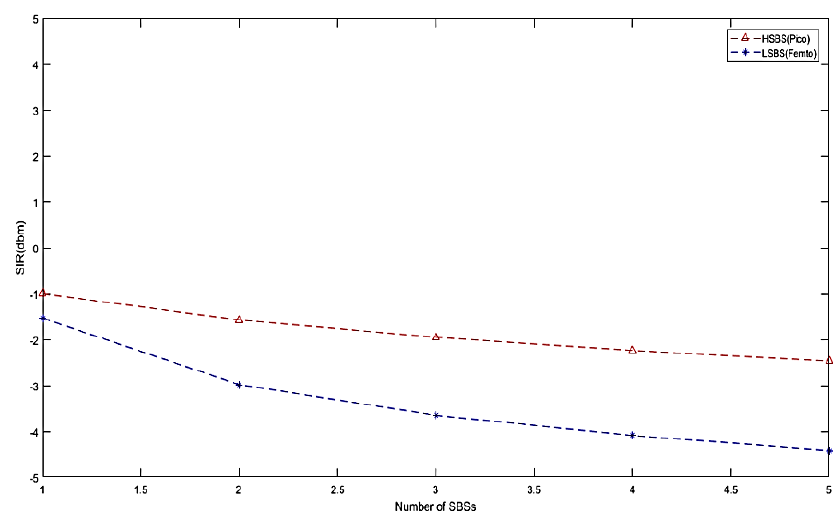
Figure 11. SIR comparison of HSBS and LSBS with the IMHC scheme.